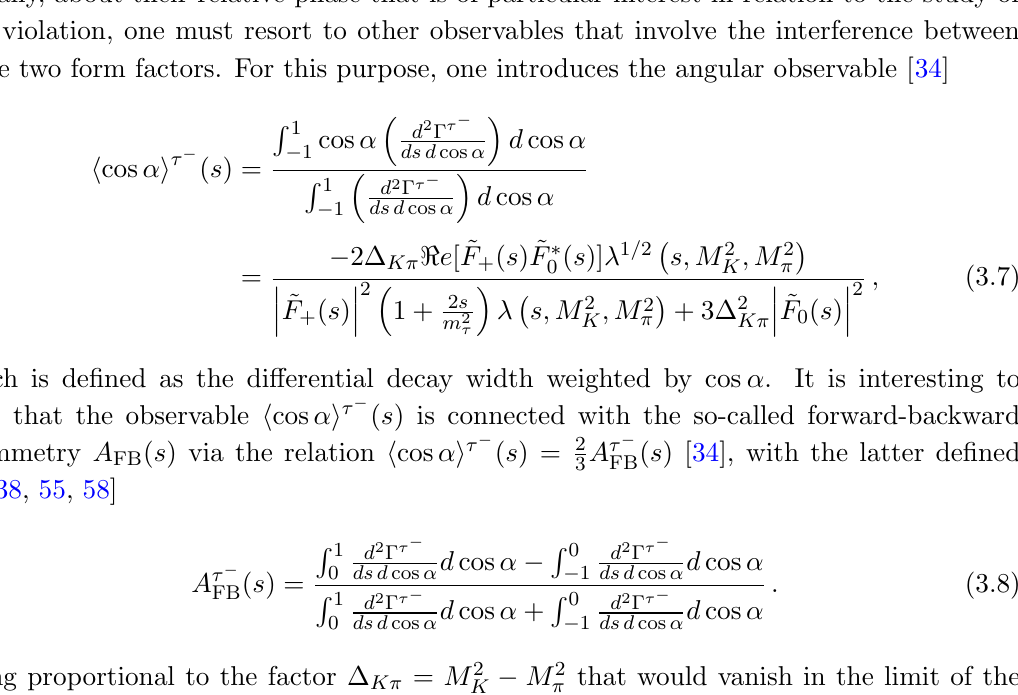
Figure 2 . The K(cid:25) invariant mass distribution of the di(cid:11)erential decay width d (cid:0) (cid:28) the (cid:28) total decay width (left) as well as the angular observable h cos (cid:11) i (cid:28) (cid:0) ( s ) (right) for the decay (cid:28) (cid:0) ! (cid:22) K 0 (cid:25) (cid:0) (cid:23) (cid:28) within the